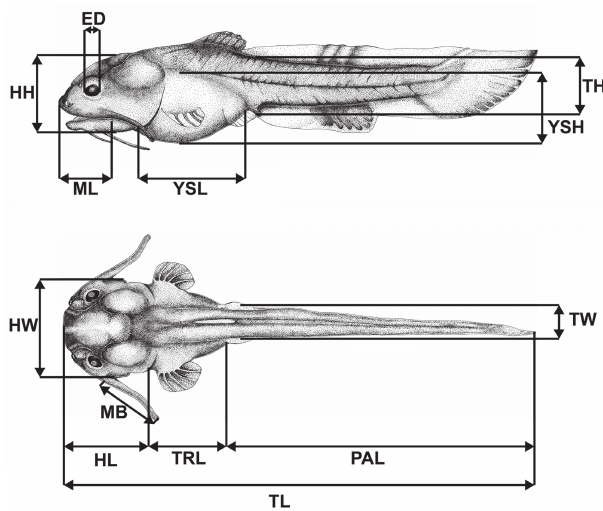
Fig. 1. Drawing of Lophiosilurus alexandri larvae ( circa 13 mm TL, 8 DAH): total length (TL), head length (HL), head height (HH), head width (HW), mouth length (ML), eye diameter (ED), maxillary barbel length (MB), trunk length (TRL), trunk height (TH), trunk width (TW), yolk sac length (YSL), yolk sac height (YSH), and postanal length (PAL).